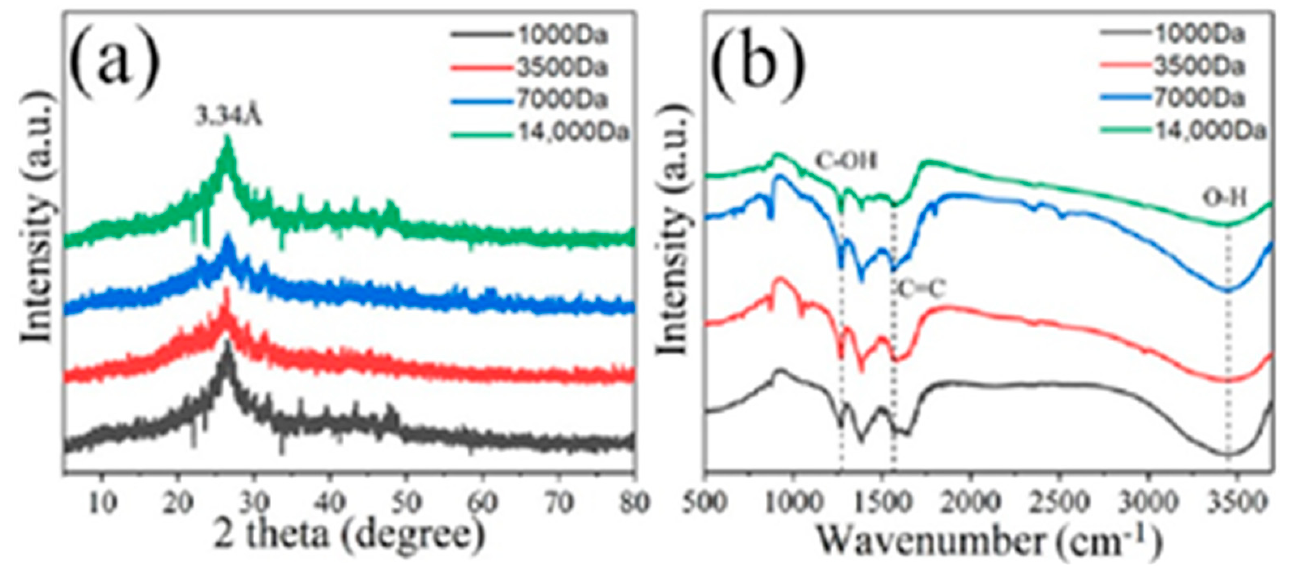
Figure 2. XRD patterns ( a ) and FTIR spectra ( b ) of four separated GQDs.